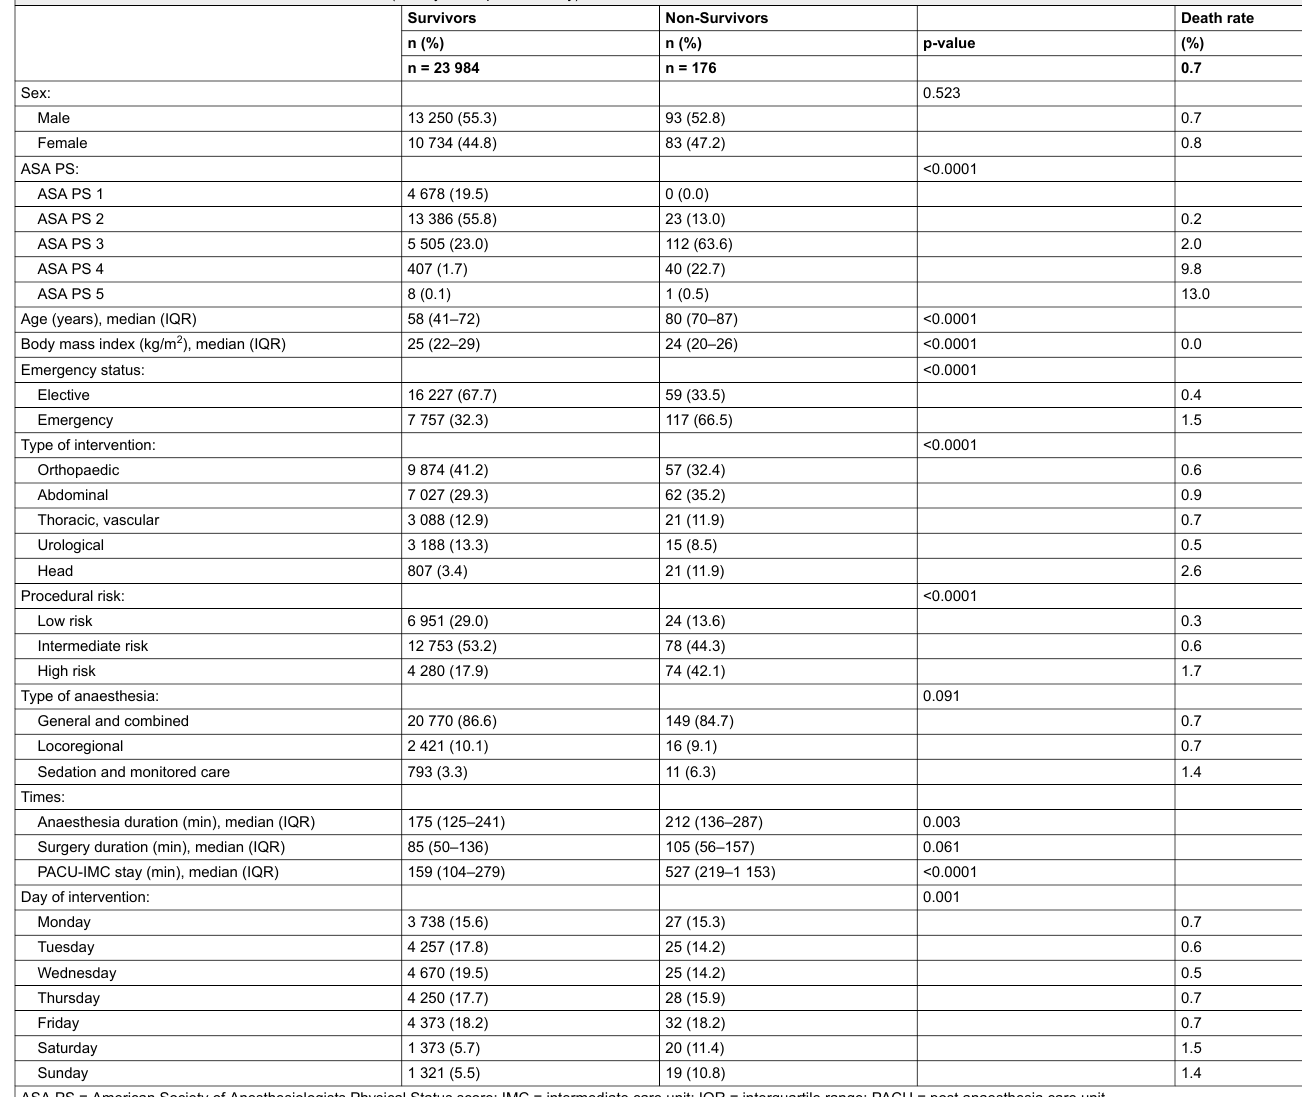
Table 2a : Characteristics of survivors and nonsurvivors (30-day in-hospital